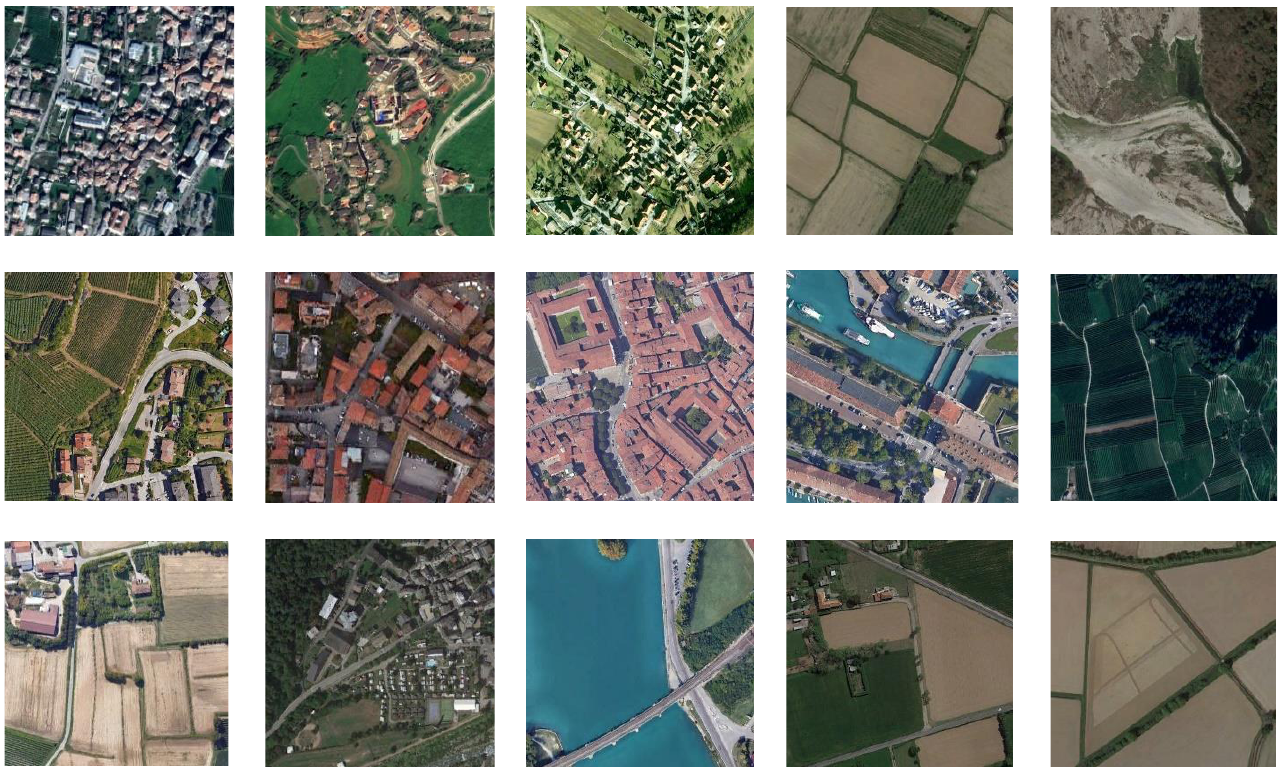
Figure 4. Some examples from the multi-scale training dataset collected and shared for the colorization of historical aerial images: the patches feature different radiometric properties and depict several built and natural environments.